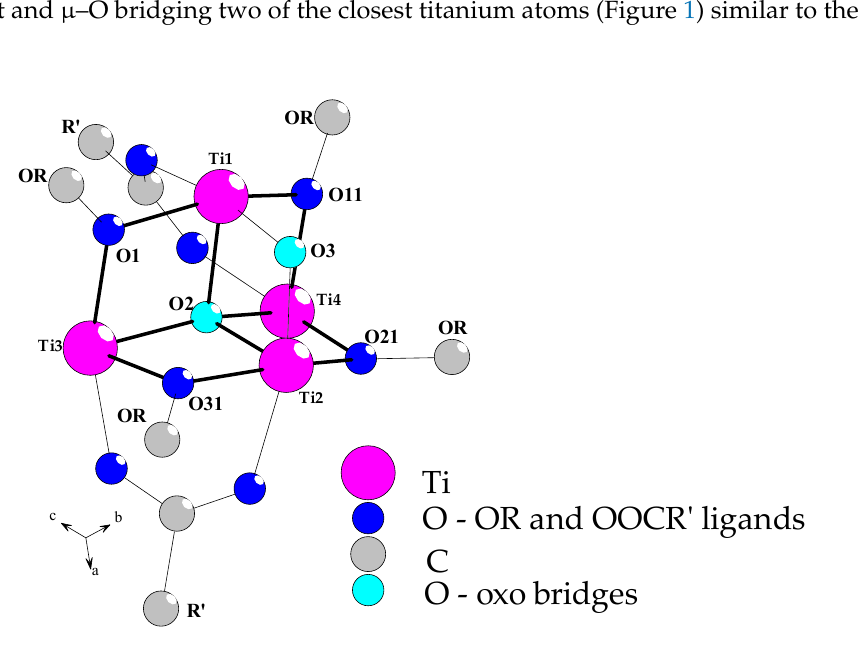
Figure 1. The structure of {Ti 4 O 2 } core, which was found in (Ti 4 O 2 (OR) 10 (O 2 CR’) 2 ) (R = i Bu, R’ = C 13 H 9 ( 1 ), PhCl ( 2 ), PhNO 2 ( 3 )) complexes (crystallographic ball-stick scheme). For clarity, the terminal alkoxide groups are omitted.